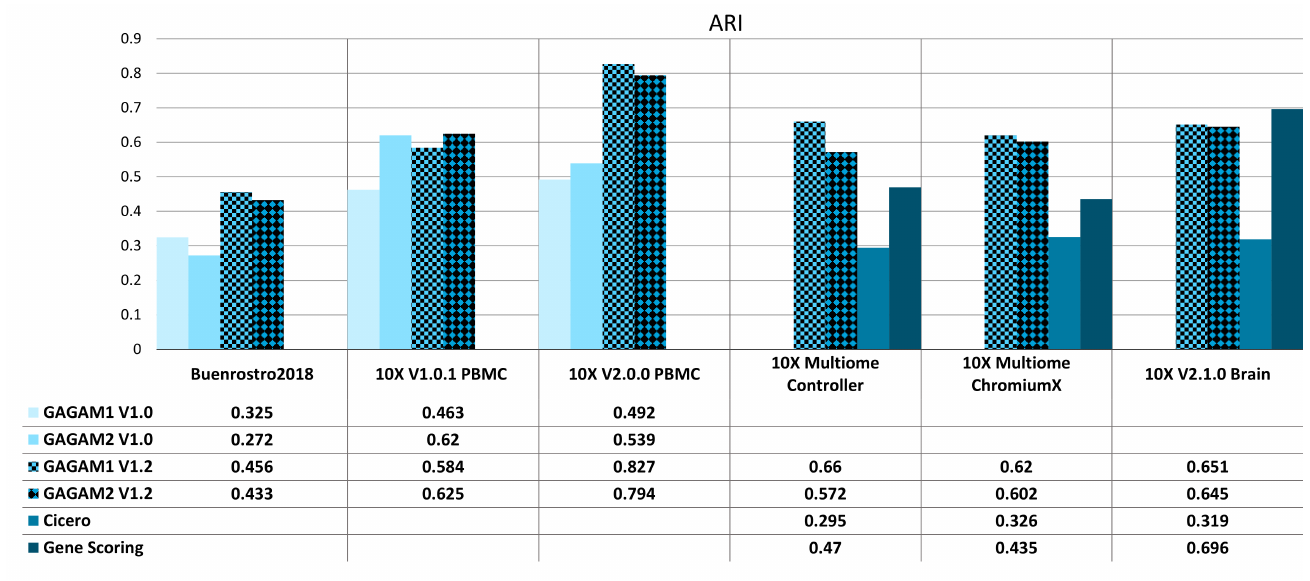
Figure 5. ARI results for both Old ( left ) and New ( right ) datasets. The Old datasets are compared with GAGAM v1.0 from [10], while the New datasets are with Cicero and GeneScoring.